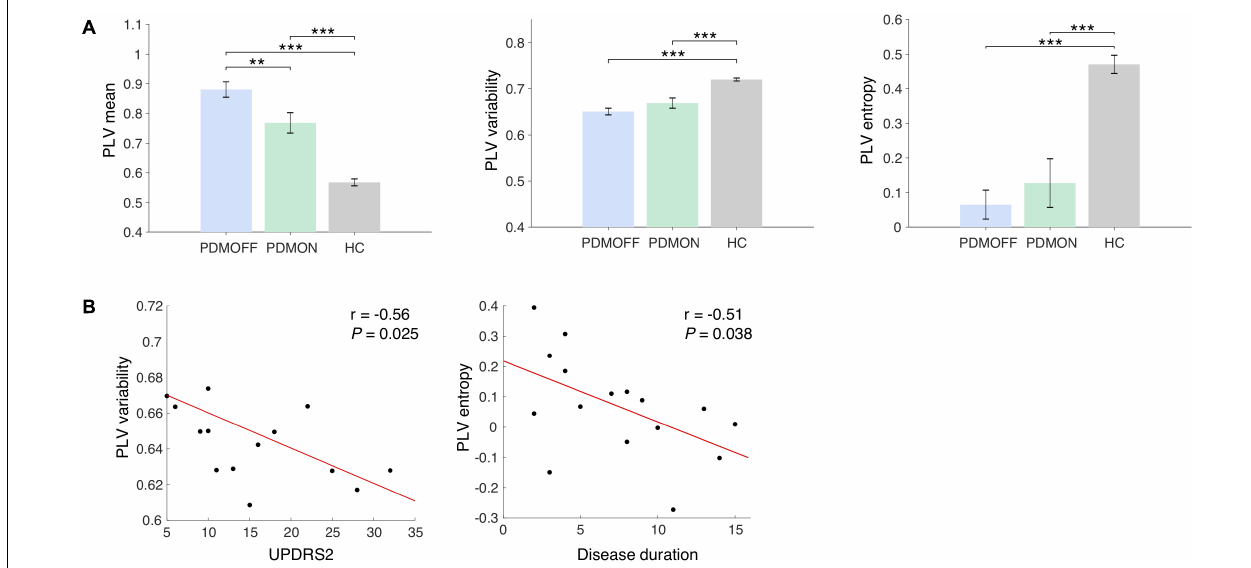
FIGURE 3 | (A) Group comparison of the discriminant component obtained from the SDA. The discriminant components were obtained by multiplying the discriminant vectors to the data sets from the sham condition. Bars and error bars indicate group means and s.e. Significant P -values from one-way ANOVA with post hoc Tukey’s HSD test are indicated ( ∗∗ P < 0.01; ∗∗∗ P < 0.001). (B) Pearson correlations with clinical scores. The PLV variability and entropy of the PDMOFF subjects are significantly correlated with UPDRS2 and disease duration,